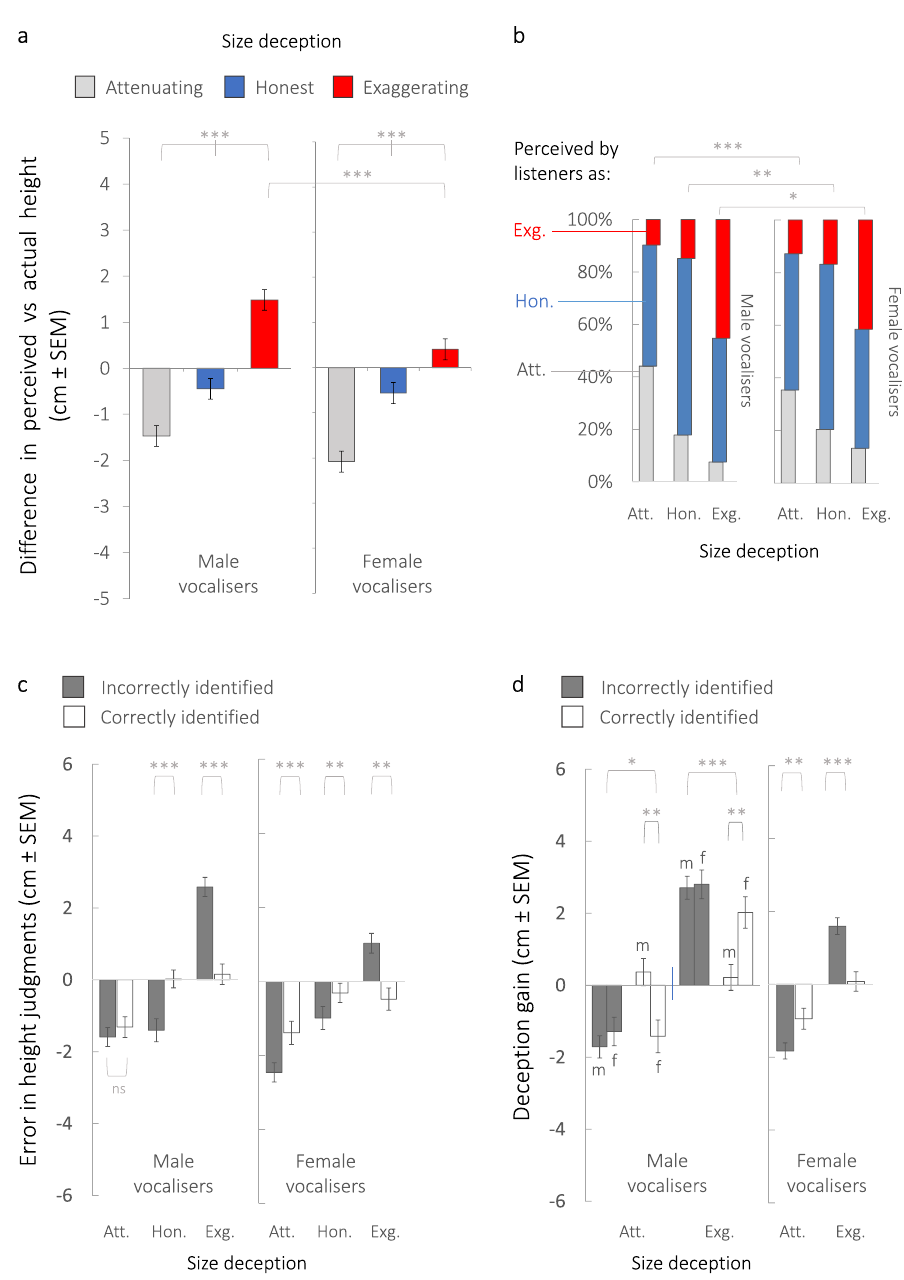
Fig. 4 Awareness reduces bias: Listeners recalibrate height judgements for signals correctly and concurrently detected as deceptive (Experiment 2). a Bias in height judgements shown as the mean difference (±SEM) between perceived and actual heights of vocalisers, in cm, for honest vocal signals (blue bars) and deceptive vocal signals (attenuating = grey bars, exaggerating = red bars). Estimated marginal means and pairwise comparisons derive from LMMs (see Supplementary Table 11), where all *** p < 0.001 following Š idák correction for multiple comparisons. Error bars ±SEM. b Percentages of vocalisers that listeners perceived as deceptively exaggerating (red bars) or attenuating (light grey bars) their size, or as producing honest vocal signals (blue bars, centre) are shown along the y -axis as a function of the intended size deception indicated along the x -axis. Estimated marginal means and pairwise comparisons derive from LMMs (see Supplementary Table 12), where *** p < 0.001, ** p < 0.01, * p < 0.05 following Š idák correction. Tests are two- tailed. c , d Bias in listeners ’ size assessments as a function of whether a listener failed to detect (dark grey bars) or correctly detected (white bars) a vocal signal as deceptive or honest, where panel c shows ‘ error ’ in height judgements (mean difference between perceived and actual heights of vocalisers), and panel d shows ‘ deception gain ’ in height judgements (mean difference between perceived height from honest signals and perceived height from deceptive signals). Panel d also illustrates that deception gain was lower for male vocalisers (left side) when correctly detected as cheating by other male listeners (labelled with ‘ m ’ ) compared to when detected by female listeners ( ‘ f ’ ). Estimated marginal means and pairwise comparisons derive from LMMs (see Supplementary Tables 13 and 14), *** p < 0.001, ** p < 0.01, * p < 0.05 following Š idák correction. Tests are two-tailed. Error bars ± SEM. Acronyms: Att. attenuating, Hon. honest, Exg. exaggerating, m male listeners, f female listeners. All data derive from Experiment 2 based on 120 vocal stimuli produced by n = 40 vocalisers (20 males, 20 females) in each of three size conditions (honest, attenuating, exaggerating) and judged by n = 98 listeners, each of whom rated all 120 vocal stimuli (see Methods). See also Supplementary Fig. 3 for dot plots illustrating the distribution of data. Source data are provided as a Source Data fi